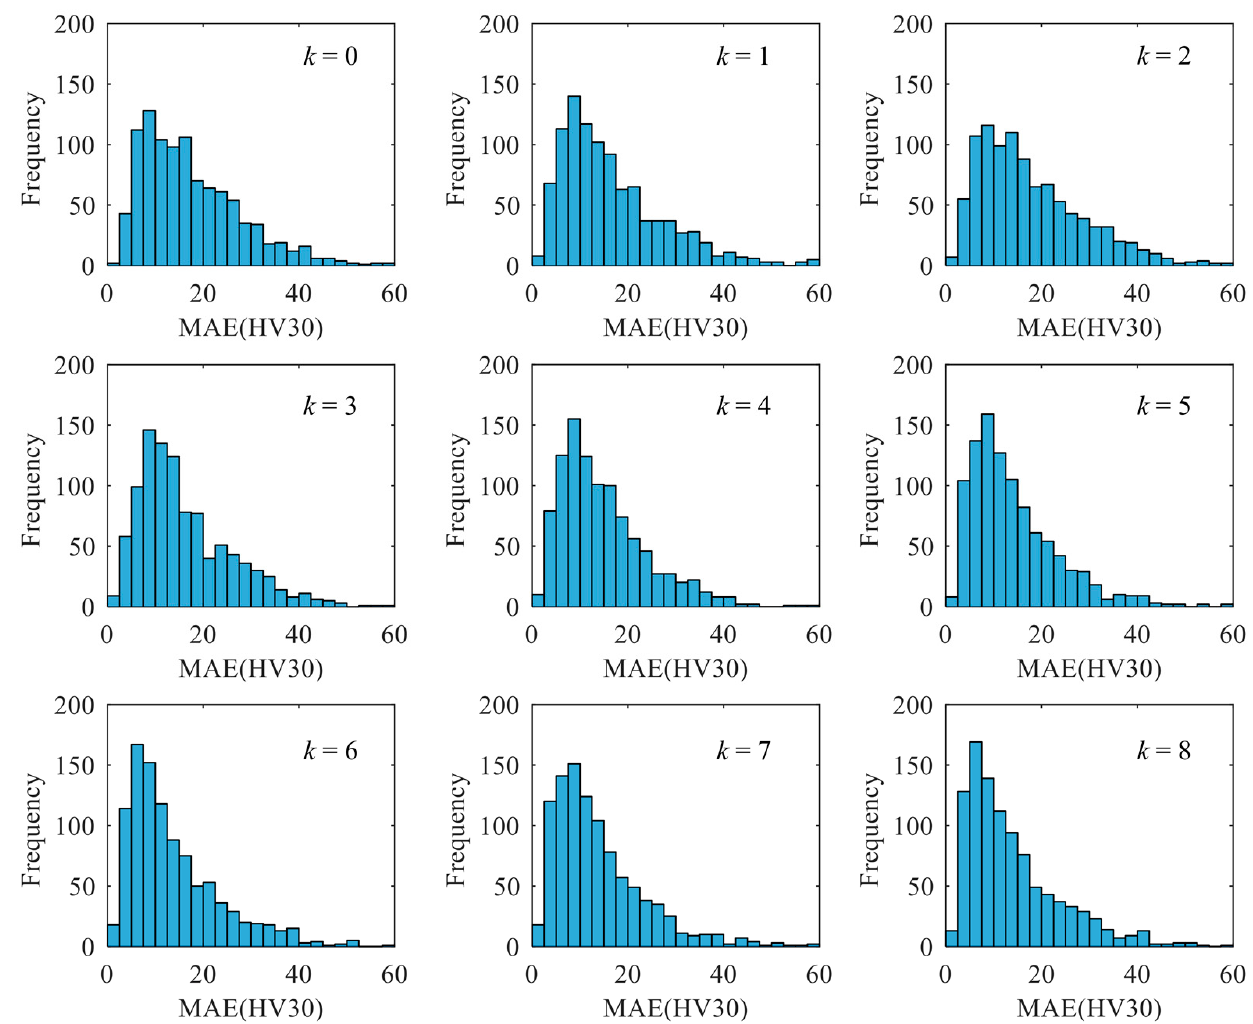
Figure 10. Histograms of MAE obtained from FNN models with different k .